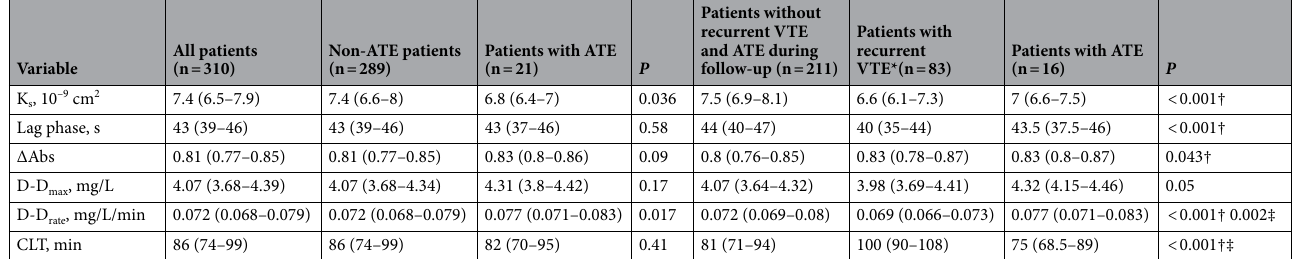
Table 2. The comparison of fibrin clot proprieties. K s, fibrin clot permeability; ΔAbs, maximum absorbance at the plateau phase; D-D max, maximum D-dimer concentrations; D-D rate , rate of increase in D-dimer levels; CLT, clot lysis time; for other abbreviations see Table 1. Values are given as median (interquartile range). In terms of ATE two patients excluded from the previous analysis were included in the current follow-up study. *Five patients with both recurrent VTE and ATE were included into recurrent VTE group as this event occurred first. † Indicates statistical difference between patients without both VTE and ATE, and patients with recurrent VTE. ‡ Indicates statistical difference between patients with recurrent VTE and patients with ATE. The presented differences between groups remained statistically significant after adjustment for age, sex, diabetes and